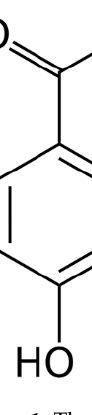
Figure 1. The chemical structure of vanillic acid .